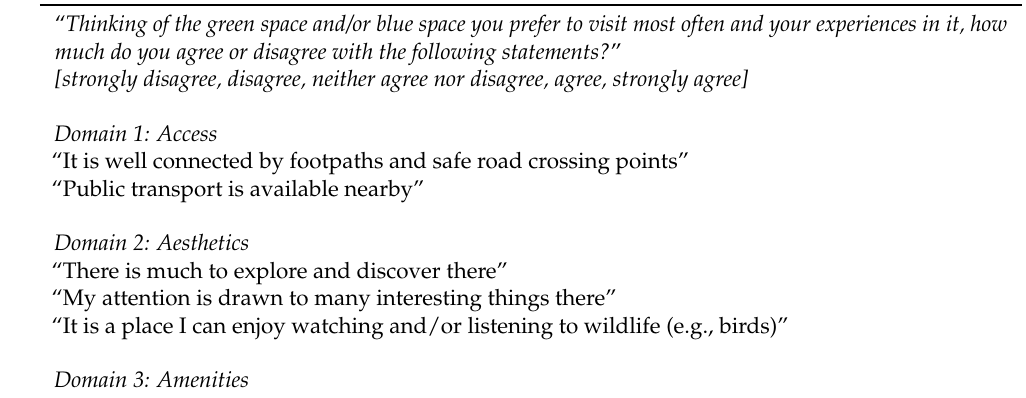
Table 1. Eighteen nature space quality indicators nested within eight quality